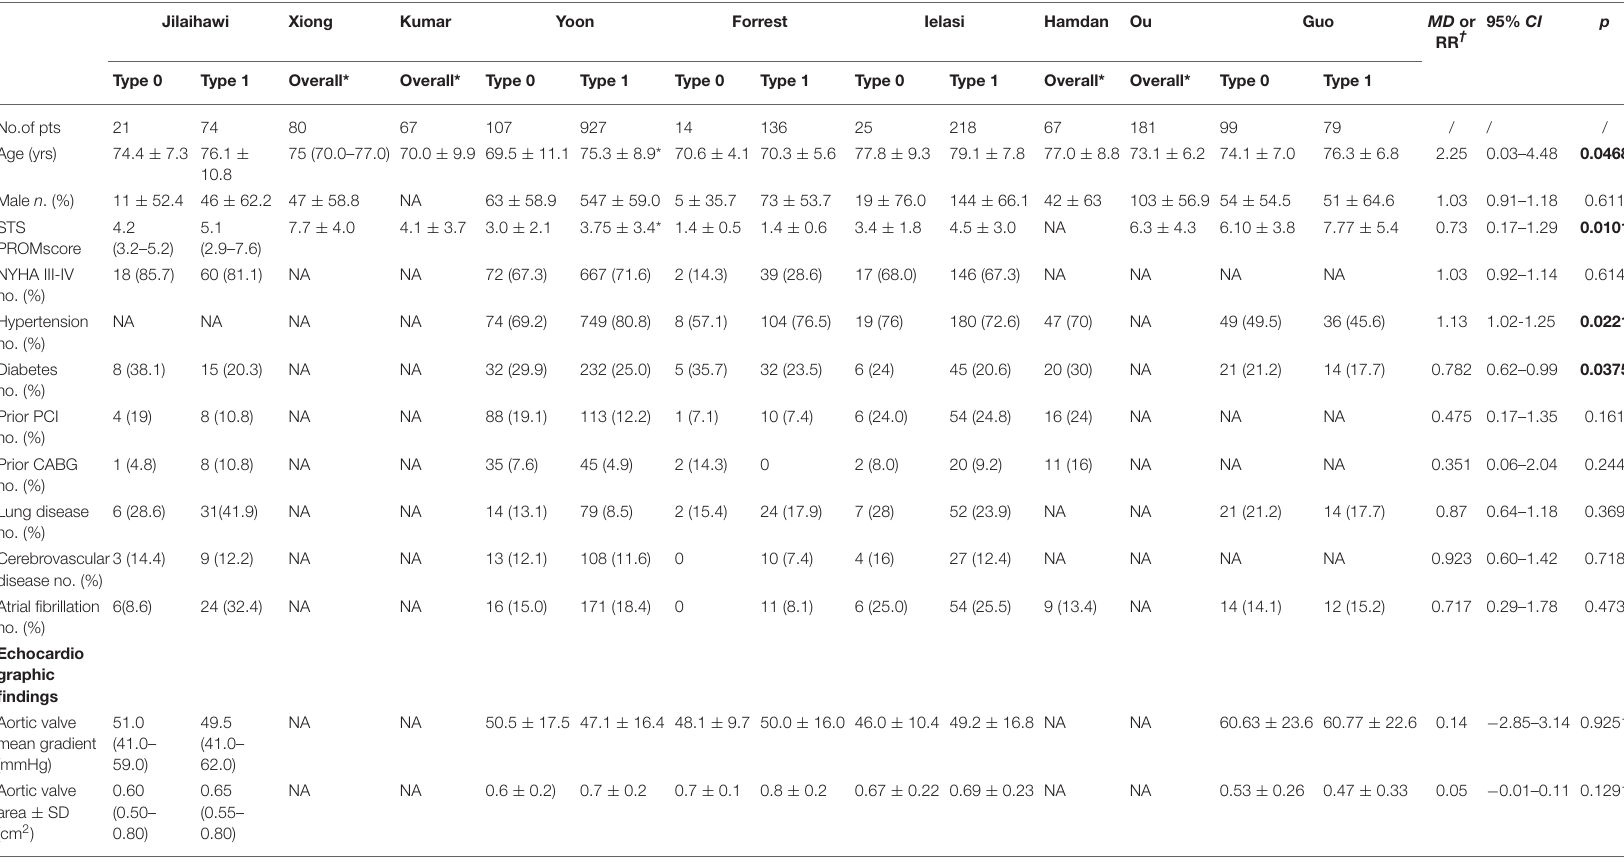
Values are mean ± SD, median (interquartile range), or n (%). * Only rates of the whole population were available. † Comparing characteristics of type 1 to type 0. † Bold values refer to p < 0.05 with significant difference between groups. CI, Confidence Interval; CABG, coronary artery bypass graft; MD, Mean Difference; RR, risk ratio; NYHA, New York Heart Association; NA, not applicable; PCI, percutaneous coronary intervention; STS PROM, society of thoracic surgeons predicted risk of